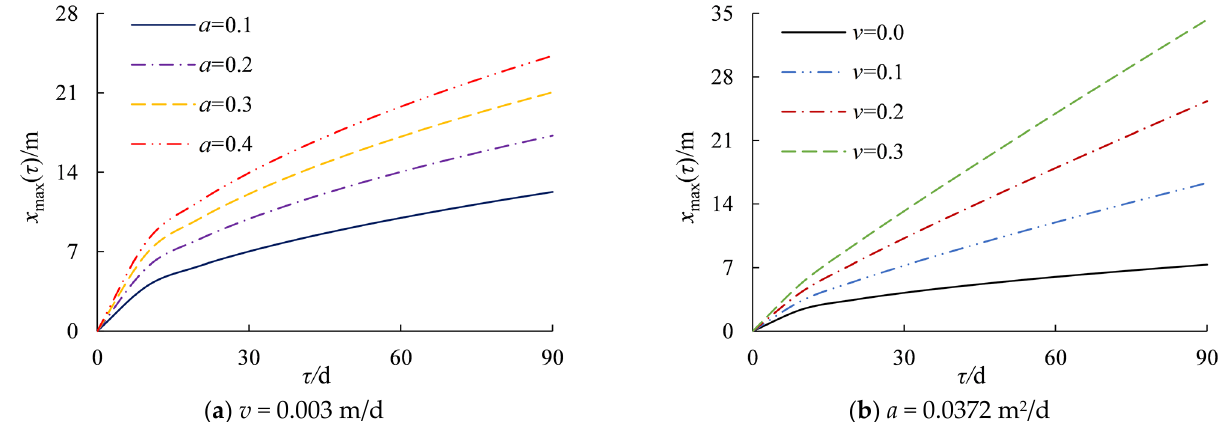
5.2. The Influence of Soil Thermal Diffusivity and Groundwater Velocity on the Heat Penetration Distance As indicated by Equation (6), the heat penetration distance x max ( τ ) is related to the inertia time τ , the soil thermal diffusivity a , and the groundwater velocity v . The variation law of x max ( τ )– τ has been given in Figure 3; only the effects of a and v on x max ( τ ) are discussed here. The curves of x max ( τ )– τ for different values of a when v = 0.003 m/d and those for different values of v when a = 0.0372 m 2 /d are illustrated in Figure 8.